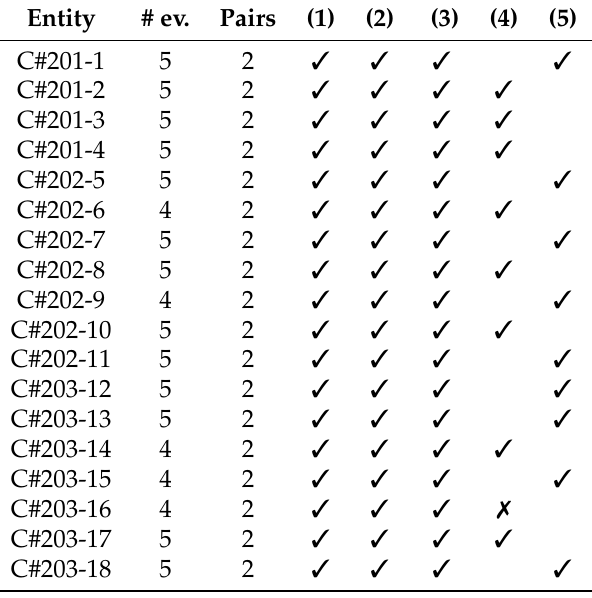
Table 12. Results of expert judgment for classes in C# programming language, with assessed quality aspects, overall quality (1); source code size (2); class complexity (3); class cohesion (4) and class coupling (5); based on an evaluation using a combination of software metrics.